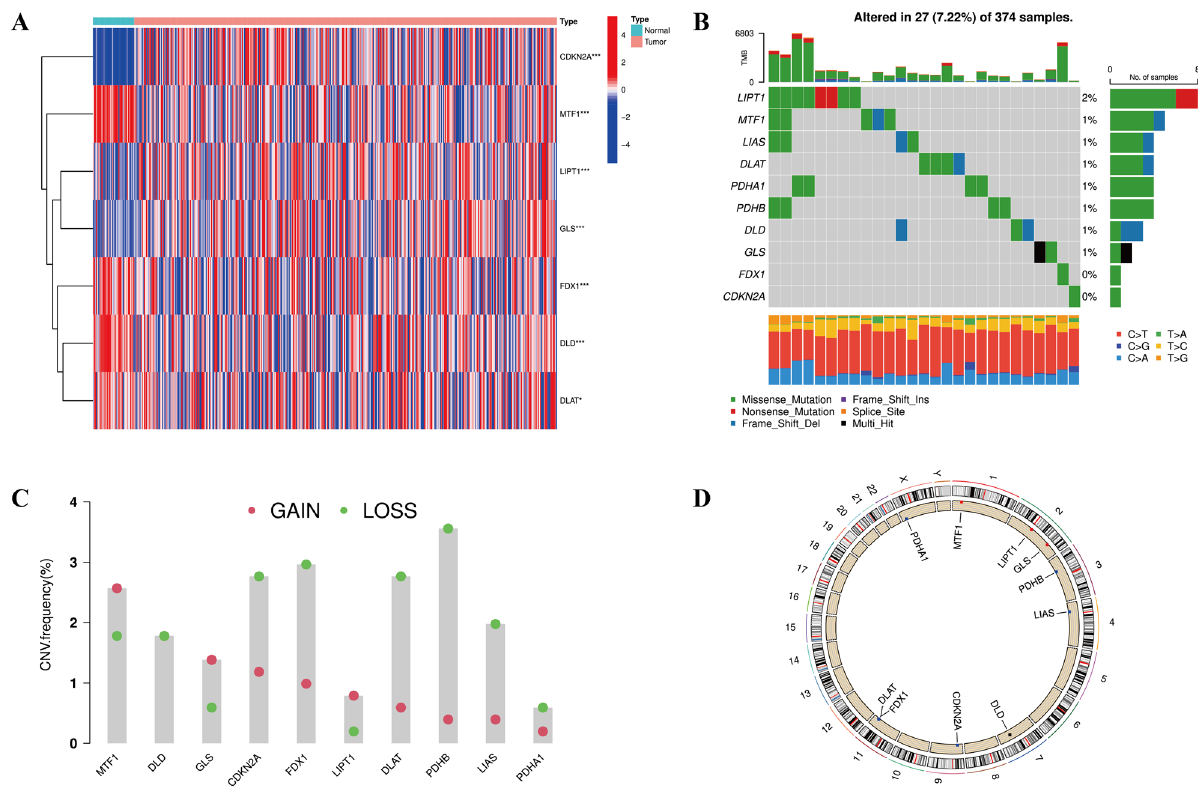
Figure 2. Cuproptosis-related gene (CRG) expression and mutations in COAD samples. ( A ) The differences in CRG expression between normal and tumor tissues. * p < 0.05, and *** p < 0.001. ( B ) The landscape of CRG mutations in 374 COAD samples. ( C ) The copy number variation (CNV) of CRGs. ( D ) The location of CRGs with CNV modification on 23